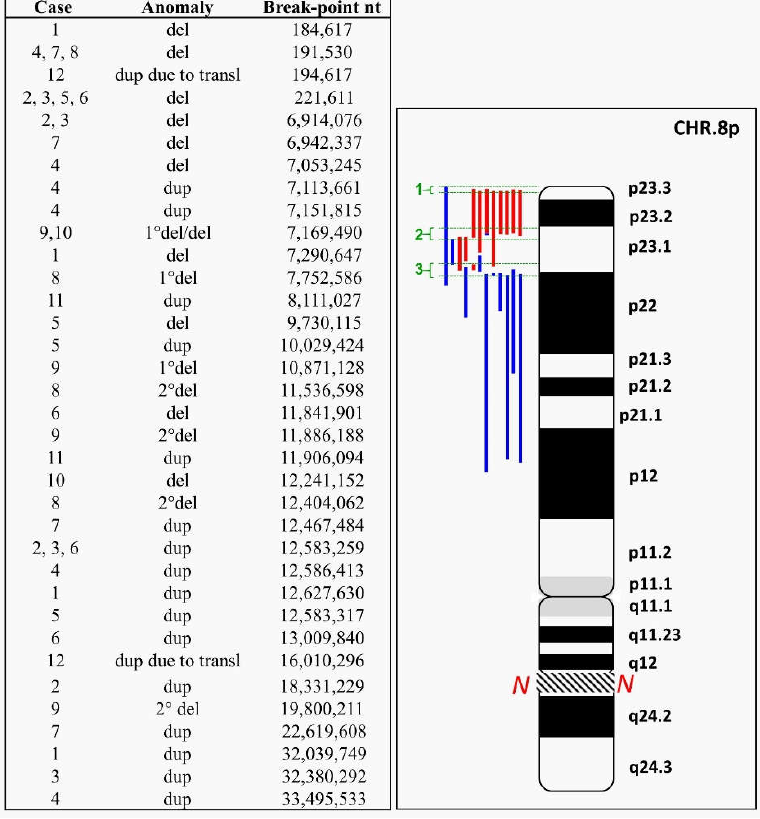
Figure 1. Graphical representation of chromosome 8 aberrations described in this study. Left: in the third column, from top to bottom, the identified breakpoints are reported from most distal to most proximal; in the middle, the alterations are specified as in the figure (see below); and in the first column, the cases in which they have been identified. Right: red bars: deletions (del); blue bars: duplications (dup). Green brackets show the most frequent breakpoint intervals: interval 1 is the most telomeric, in 8p23.3, from nt 184,617 to nt 221,611; intervals 2 and 3 are in 8p23.1, from nt 6,942,337 to nt 9,730,115 and from nt 10,029,424 to nt 12,627,630, respectively. The region of the 8q arm not shown in the figure is indicated by the N .